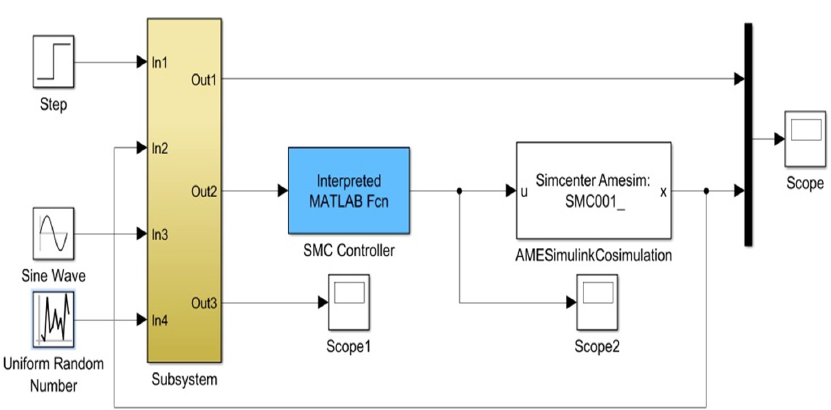
Figure 3. AMESim/Simulink co-simulation block diagram .